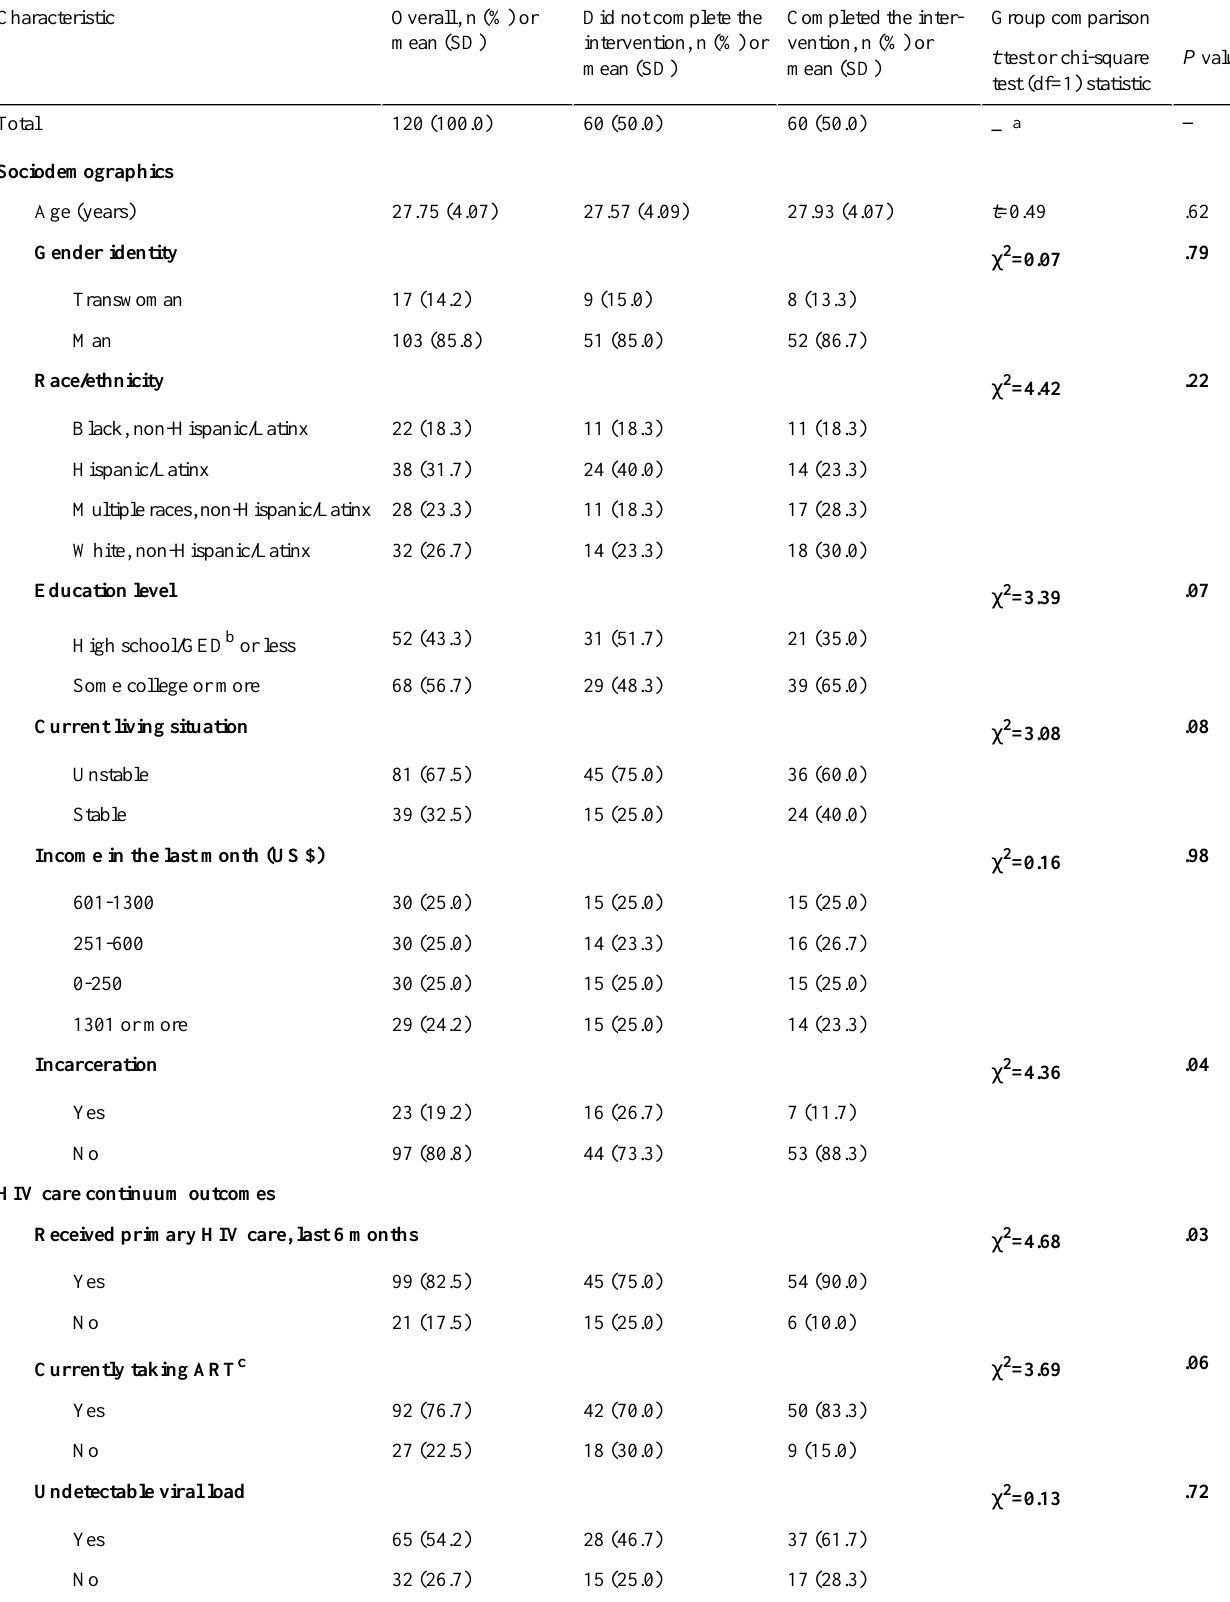
Table 1. Differences in baseline sociodemographics and HIV care continuum outcomes among young men who have sex with men and transwomen overall and according to intervention completion (Health eNav,